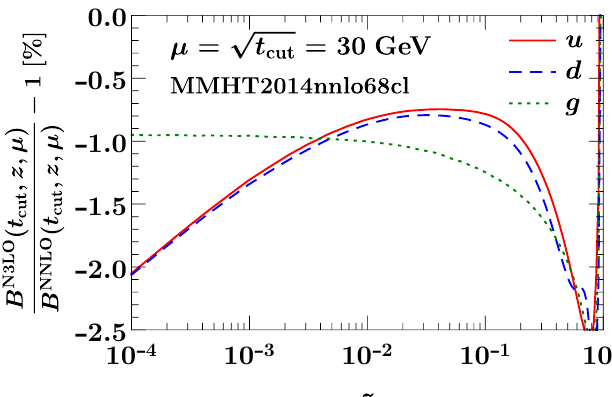
Figure 4 . The K -factor of the N 3 LO beam function, i.e. the ratio of the N 3 LO contribution p to the NNLO beam function.We (cid:12)x (cid:22) = t cut = 30 GeV, such that the shown beam function corresponds to the boundary term in a resummed prediction. The di(cid:11)erent colors show the results for an u -quark, d -quark and gluon,